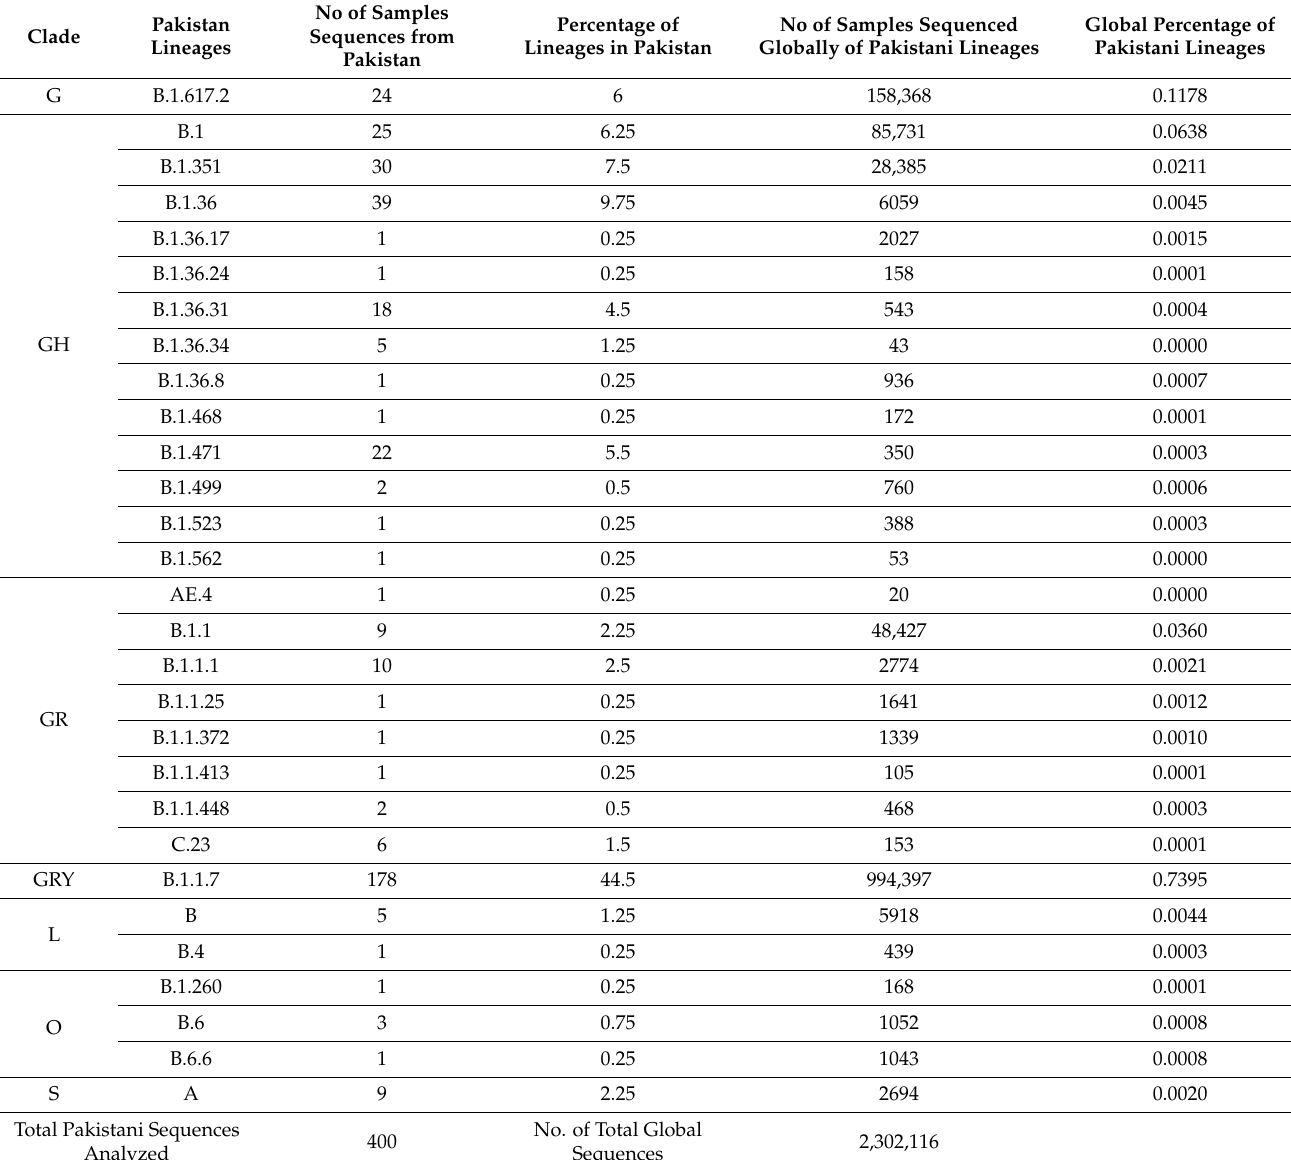
Table 2. List of 29 lineages of SARS-CoV-2 observed in Pakistan along with their local and global